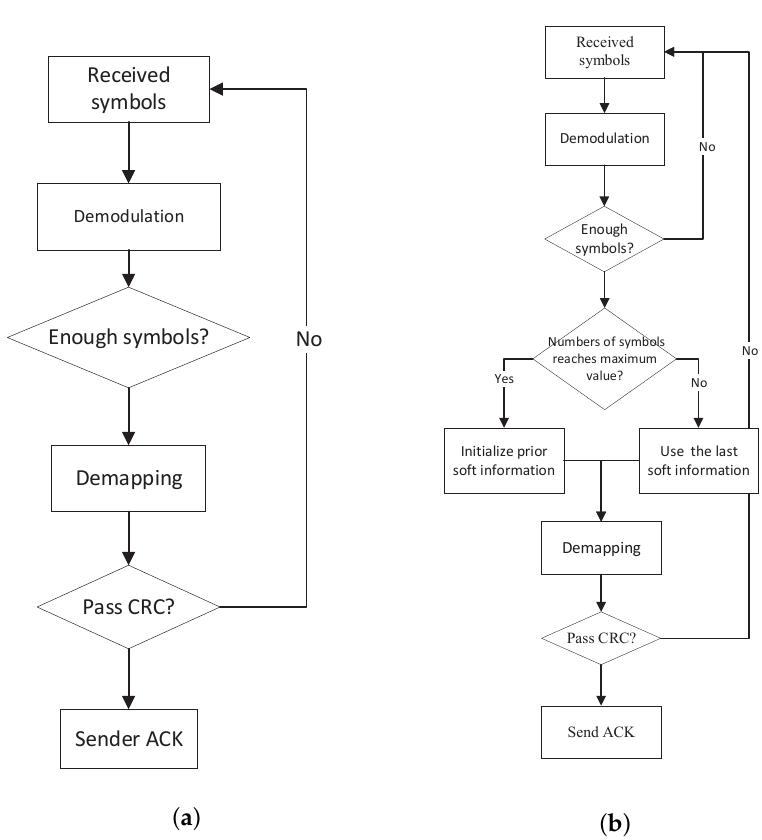
Figure 2. Comparison between original receiver model and improved receiver model. ( a ) Original receiver model. ( b ) Improved receiver